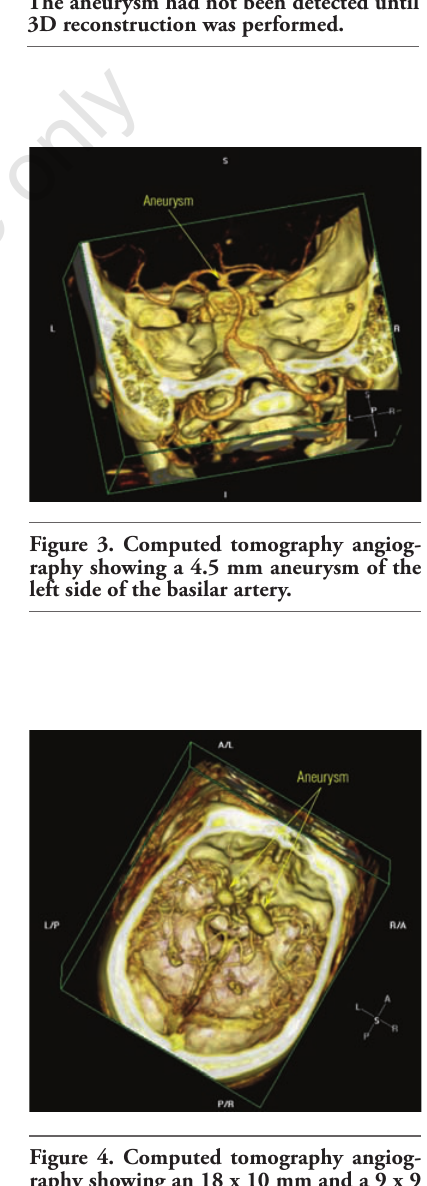
Figure 1. Computed tomography angiog- raphy showing a 4 mm aneurysm in the M1 segment of the left middle cerebral